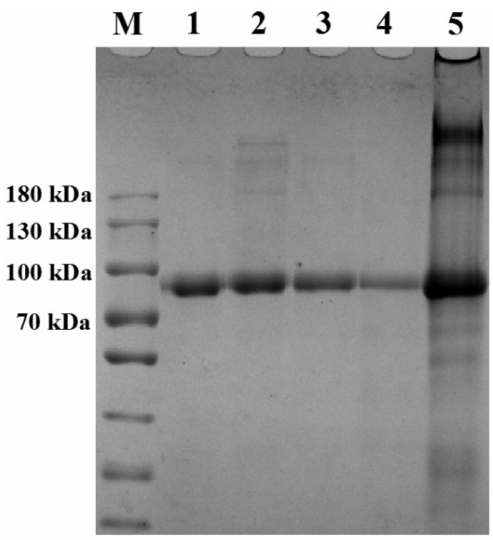
Figure 2. SDS-PAGE of LF, U-LF, M-LF-BP, D-LF-BP and C-LF-BP. M: Marker (10–180 kDa); lane 1: LF; lane 2: U-LF; lane 3: M-LF-BP; lane 4: D-LF-BP; lane 5: C-LF-BP.